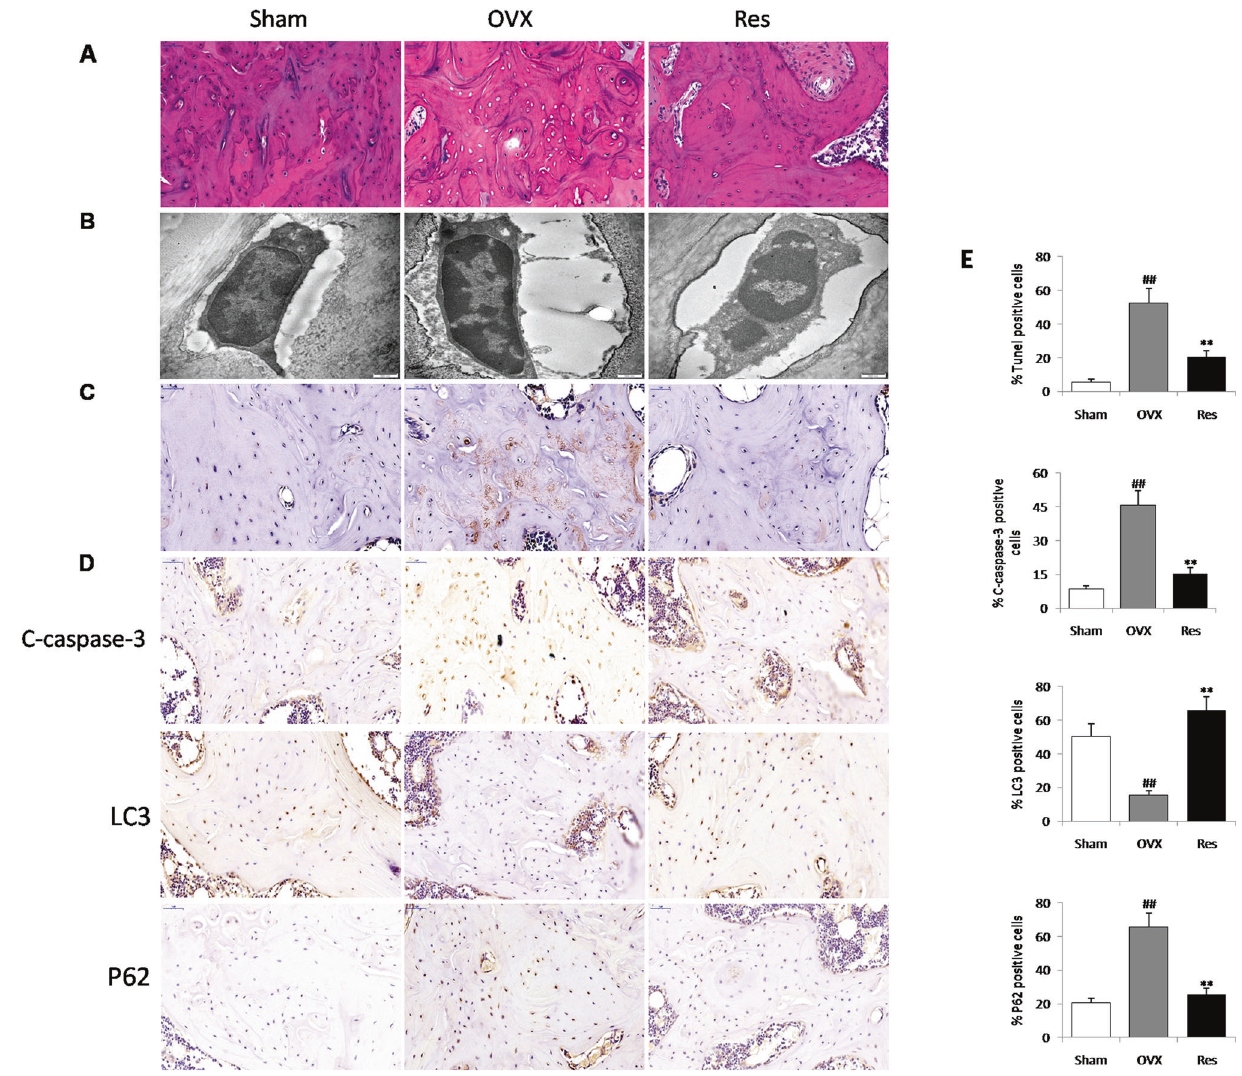
Fig. 7 Resveratrol administration induced autophagy and inhibited apoptosis of osteocyte in ovariectomized rats. A Several osteocytes inside the lacunae are observed by hematoxylin-eosin staining. B Ultrastructural architecture of osteocytes in the proximal tibia. C The percentage of apoptotic osteocytes was assessed by Tunel staining in the proximal tibia. D Osteocyte-enriched bone sections were analyzed by immunohistochemistry for Cleaved caspase-3, LC3, P62. E Histomorphometric quanti fi cations of the osteocytes number, ## P < 0.01 vs. Sham group; ** P < 0.01 vs. OVX